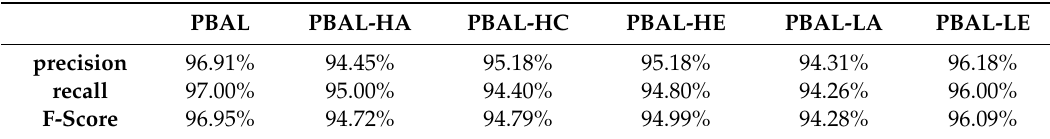
Table 9. Experimental results of the personality and bagging algorithm (PBAL) method lacking a set of personality in dataset 1.